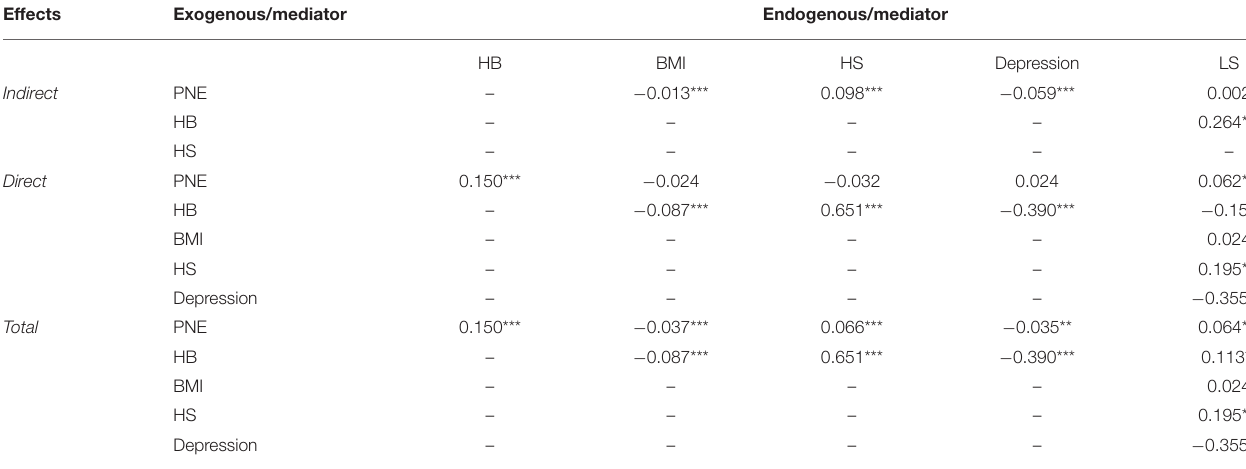
TABLE 4 | Indirect, direct, and total effects (standardized